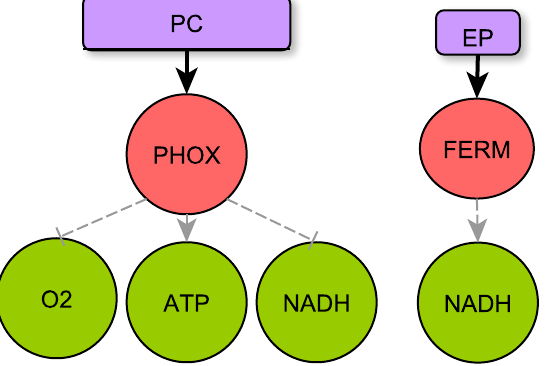
Figure 6. resources and targets for FERM and PHOX variables.